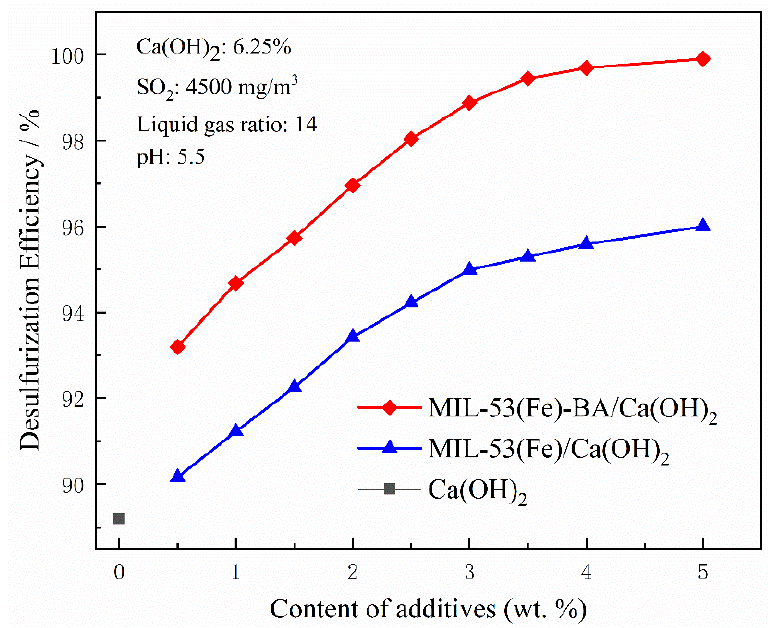
Figure 8. Effect of additive amount on desulfurization efficiency.